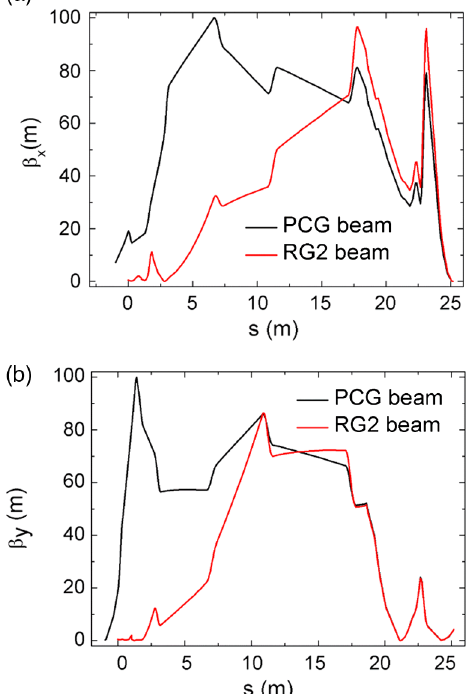
FIG. 8. (a) Horizontal and (b) vertical beta functions for RG beam (black color) and PCG beam (red color). Beta functions for both beams are the same at the end point. Note that starting positions for both beams are not consistent due to different beam line lengths.